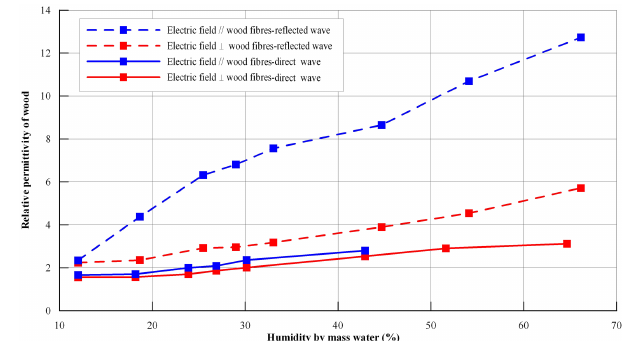
Figure 7. Relative permittivity as a function of humidity by mass water, estimated using the direct-wave (WARR) and reflected-wave methods for both polarisation